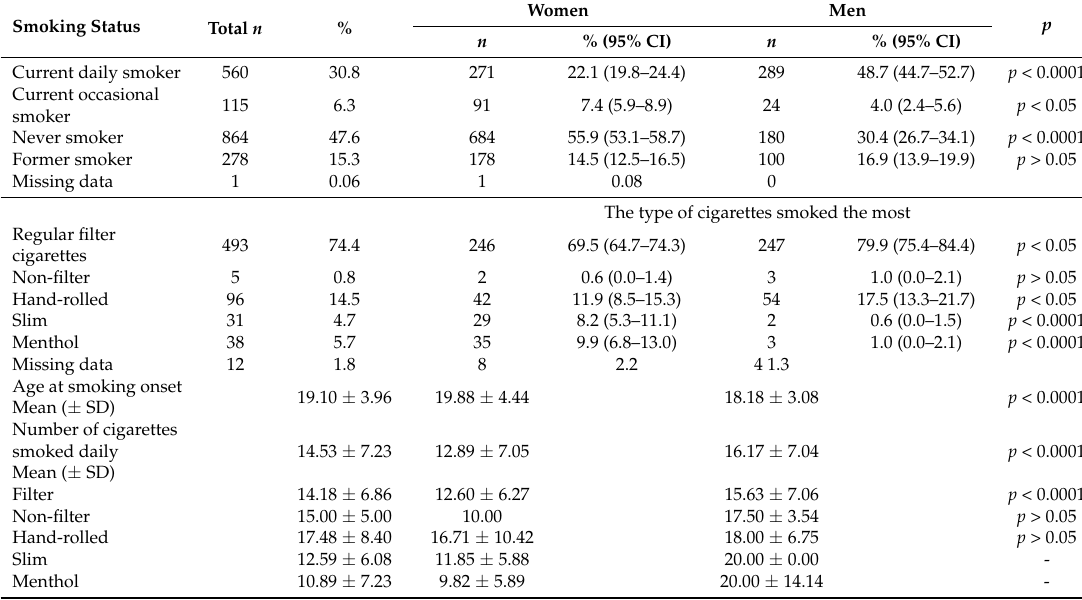
Table 2. Smoking characteristic of the study sample n =